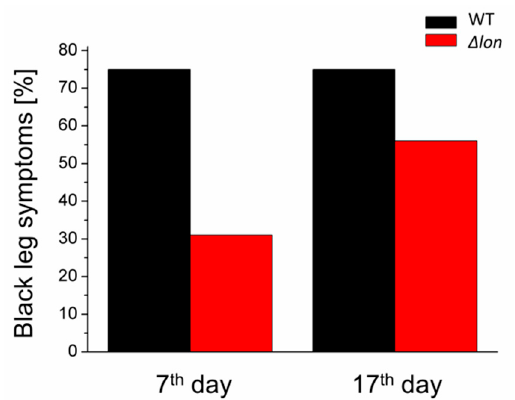
Figure 5. Pathogenicity of D. solani ∆ lon in the whole potato plant model. Potato plants cv. Vineta were infected with WT and lon mutant strains. After 7 and 17 days of incubation at room temperature with a 16/8 photoperiod, the number of plants with blackleg symptoms was counted. Four plants watered with Ringer buffer represented a negative control. The number of infected plants with WT and ∆ lon mutant was 16 for each strain.